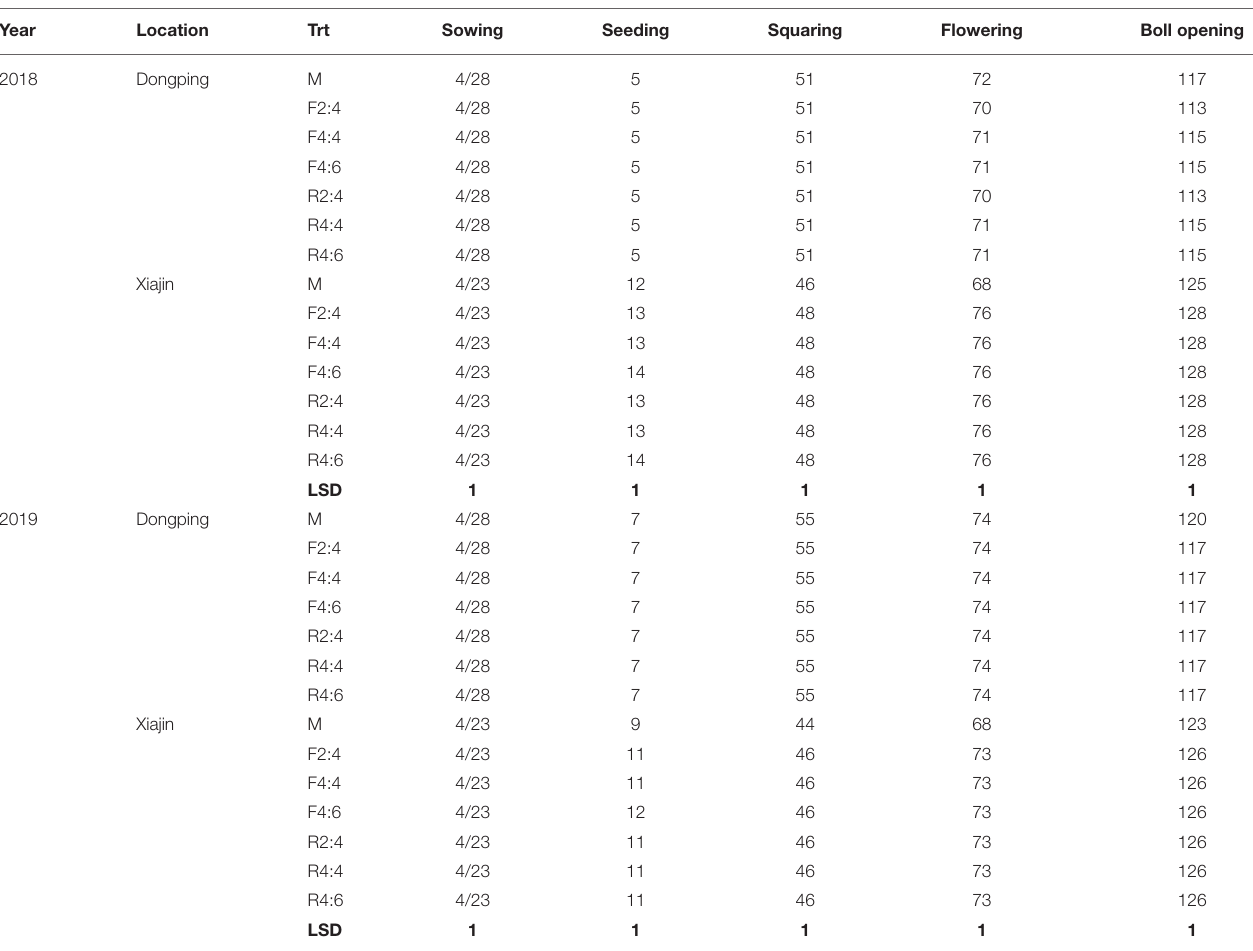
TABLE 1 | Cotton growth and development process (days after sowing) in Dongping and Xiajin counties from 2018 to 2019. Year Location Trt Sowing Seeding Squaring